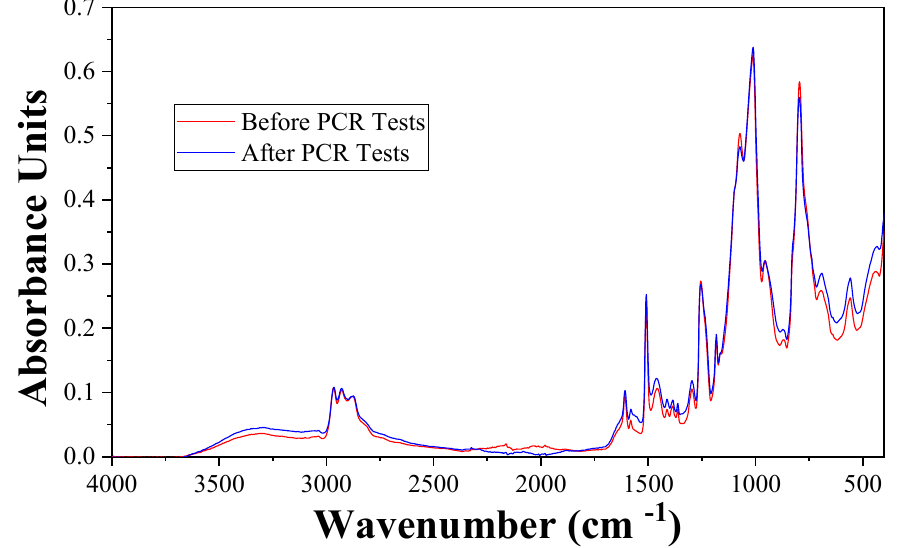
Figure 6. FTIR spectrum of the coated aluminum-based chip surface before and after running a real-time PCR test.